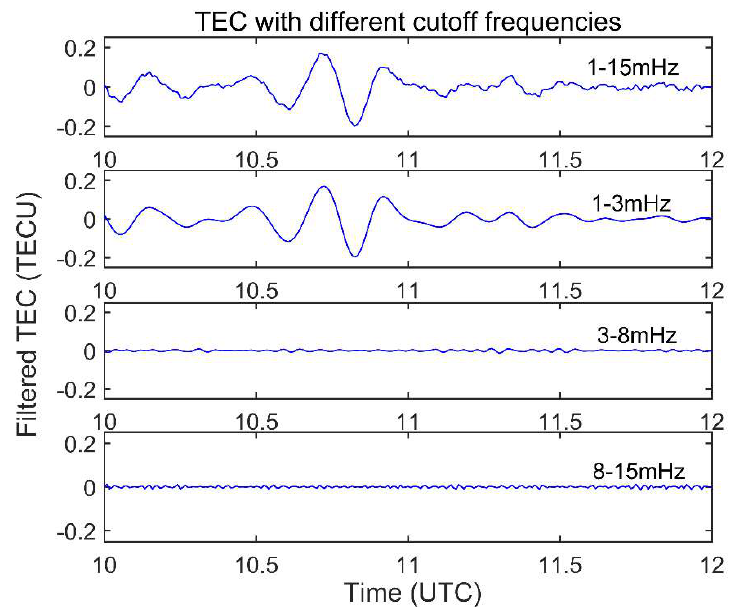
Figure 2. Total electron content (TEC) time series filtered by different cutoff frequencies observed by station DAJN and satellite PRN06 on July 10, 2018 .